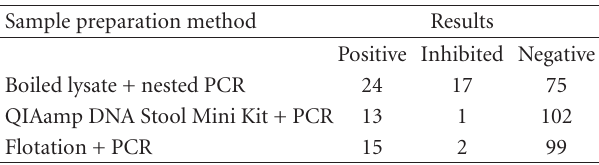
Table 3: The results from PCR analysis of 116 clinical samples previously judged as positive, negative, or inhibited by boiling and nested PCR, prepared by the finally selected flotation setup. The results from two other, previously used methods are included for